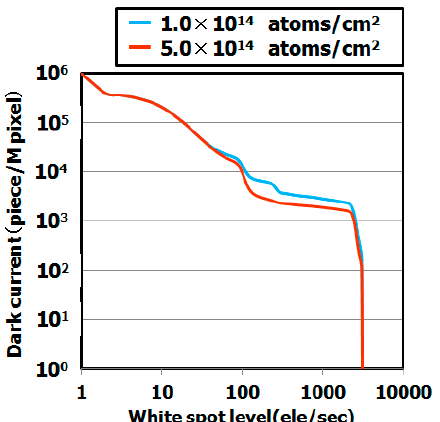
Figure 10. Dark current level of CMOS image sensor depending on hydrocarbon–molecular–ion dose. The dark current levels were measured by dark current spectroscopy under 60 °C. The epitaxial thickness is 5 µ m.